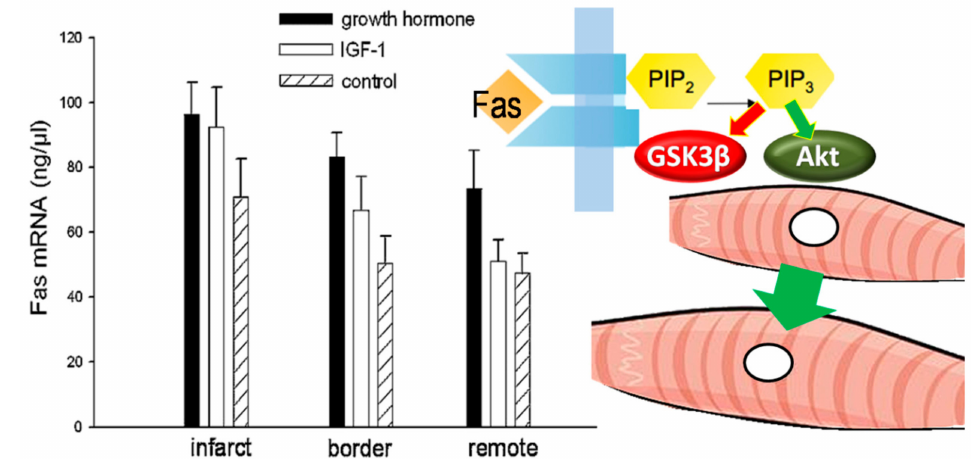
Figure 7. Cardiomyocyte hypertrophy. A possible mechanism of hypertrophy induced by growth hormone may be mediated by Fas, which inhibits glycogen synthase kinase 3 β (GSK3 β ) and activates Akt / protein kinase B. This process is dependent on the activation of the phosphoinositide 3-kinase (PIP 3 ). Containing data from Hatzistergos et al., Growth Horm IGF Res 18 (2008) 157–165 [19], with